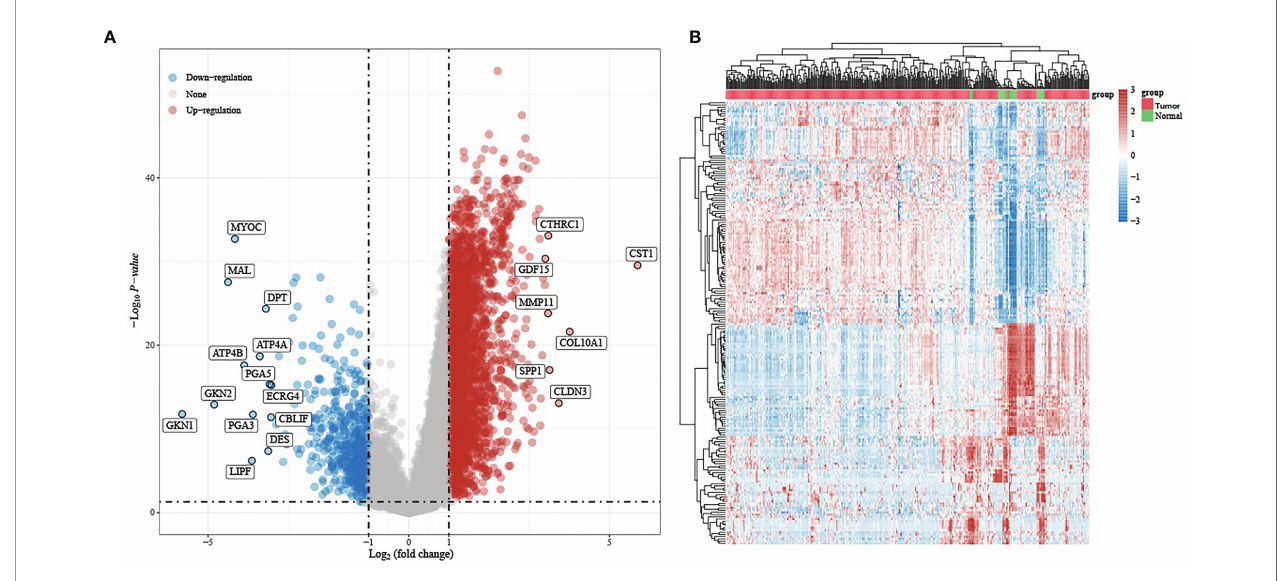
FIGURE 2 | Differential expression analysis: (A) volcano plot of differentially expressed genes, with red indicating up-regulated genes and blue indicating down- regulated genes; (B) heat map of differential gene expression.